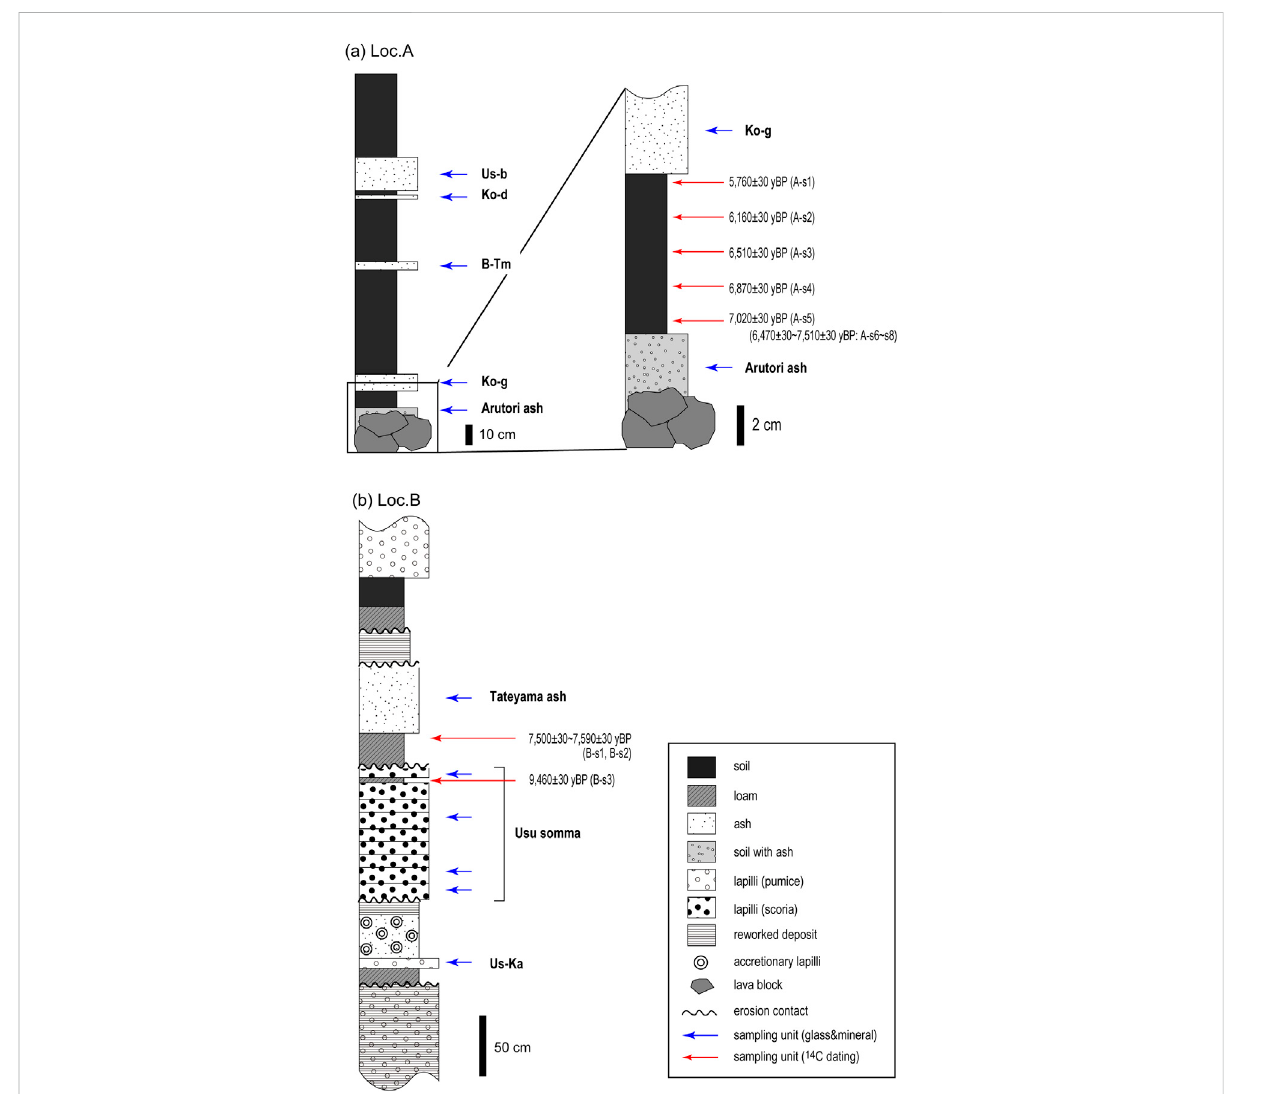
FIGURE 6 Stratigraphic columns ofthesection atLocalities A (A) and B (B) .Photographs ofeach sectionare shown inFigures7, 10.Stratigraphic positions of tephra and soil samples are marked by a blue and red arrow, respectively. Tephras were correlated to marker tephras (see Table 1) based on chemicalcompositionsofvolcanicglass.Radiocarbonagesarealsoshown.UnknownvolcanicashfalldepositswerenamedArutoriashatloc.A,and Tateyama ash at loc.